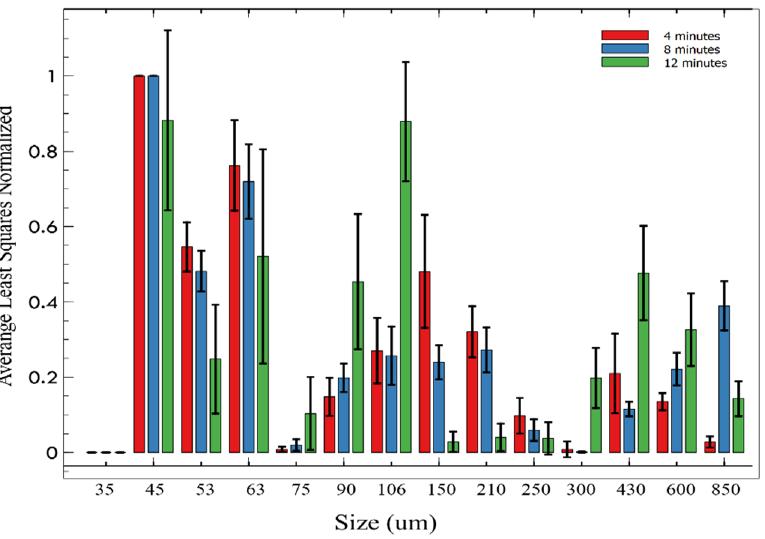
Figure 6. Normalised mean error for comparative grinding time for RRM, with 95% confidence.